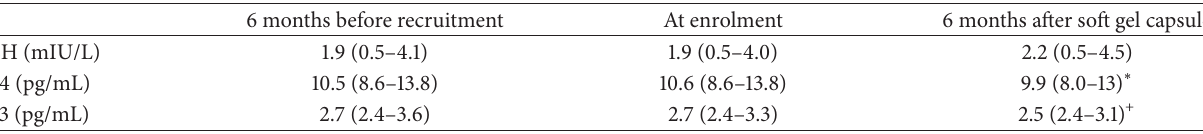
Table 2: Thyroid hormone levels six months before recruitment and at enrolment (both when taking liquid L-T4) and after 6 months’ treatment with L-T4 soft gel capsules.